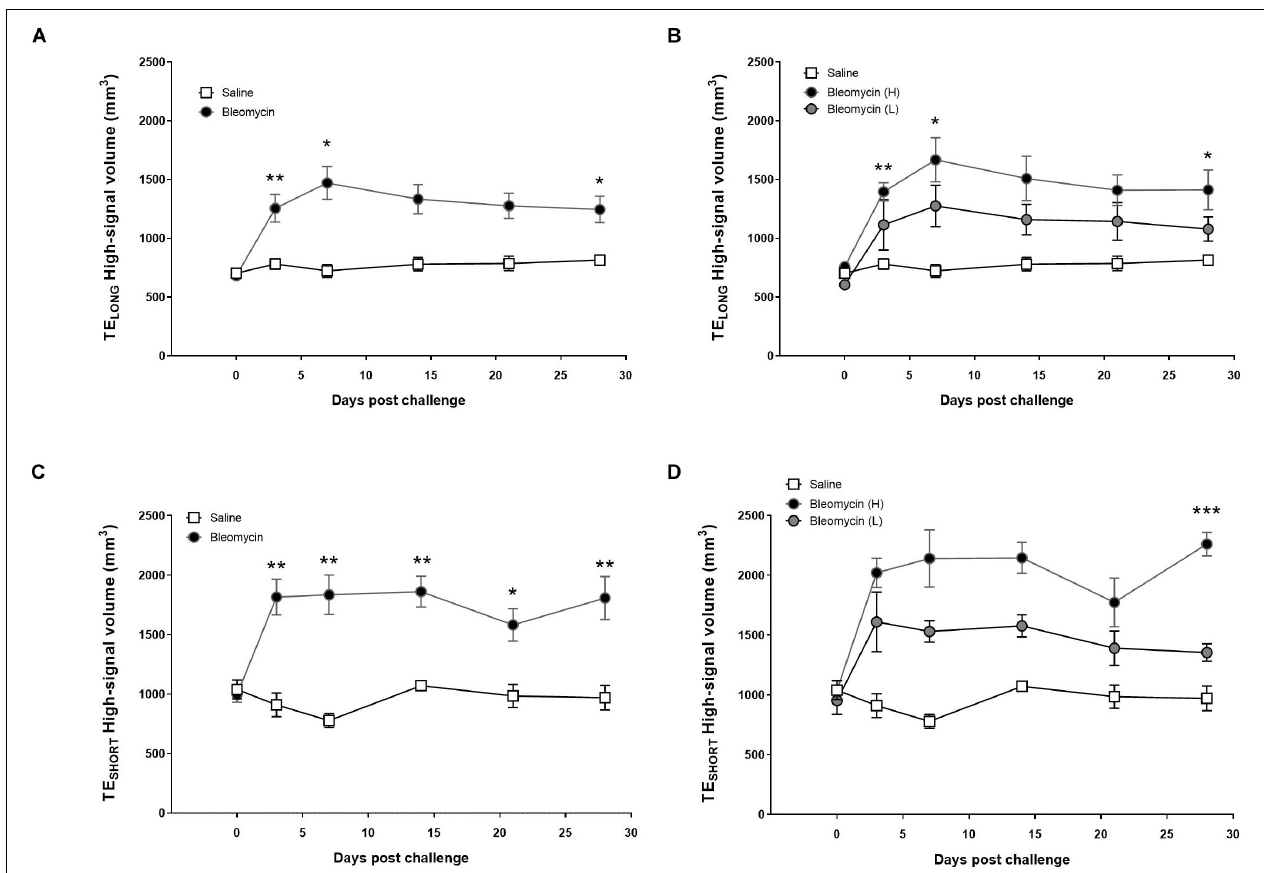
FIGURE 5 | Observation of the high MRI signal from TE LONG and TE SHORT measurements, showing lesions from inflammation and fibrosis. (A) The high-MRI signal volume, applying TE LONG , in saline vs. bleomycin-challenged rats ( n = 8). (B) When splitting the bleomycin group in high- vs. low-responders ( n = 4 + 4), it is evident that the volume of assessed lesions is being reduced to similar levels as saline controls, while the high-responder group showed continuous large volume of the lesions at the last scan session (day 28). (C) Measuring the high signal throughout the various time points with the TE SHORT , displayed mainly fibrosis at later stage, in saline vs. bleomycin-challenged rats ( n = 8). (D) The TE SHORT measurement that identifies the high signal presented according to the split bleomycin groups in high- vs. low-responders ( n = 4 + 4). Here the lesion volume is starting to recover toward saline controls in the low-responders, while the high-responder group showed progressive disease in forms of fibrotic lesions increasing significantly in volume, at the last scan session (day 28). Significance is indicated by * when p < 0.05; p < 0.01 by ** and p < 0.001 by ***, when comparing bleomycin towards the saline control from the same time